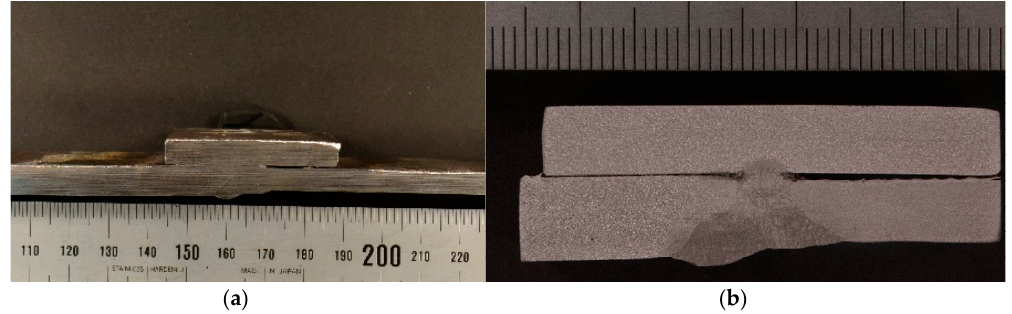
Figure 3. Complete butt penetration welded joint of 8 mm plate to 6 mm tube test specimens. ( a ) As welded coupon; ( b ) Macrographic examination of the welded coupon showed in figure ( a ).